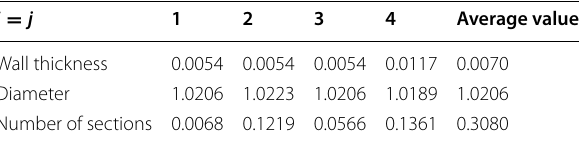
Table 6 Sensitivity analysis under different